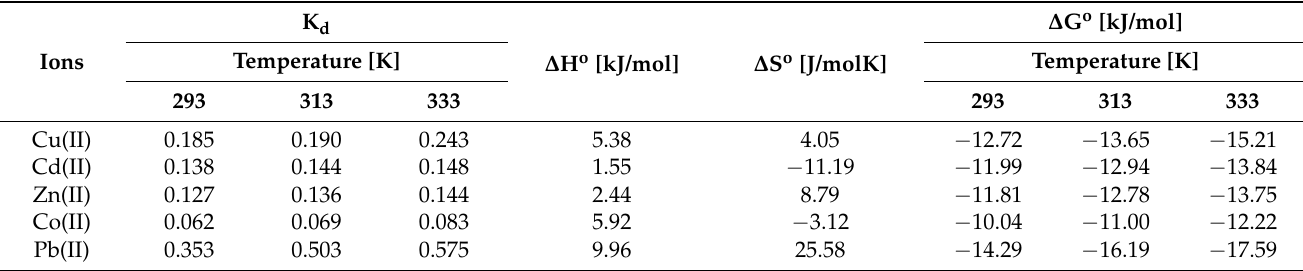
Table 5. Thermodynamic parameters for the sorption of Cu(II), Cd(II), Zn(II), Co(II) and Pb(II) ions on BC-CS 1-1.